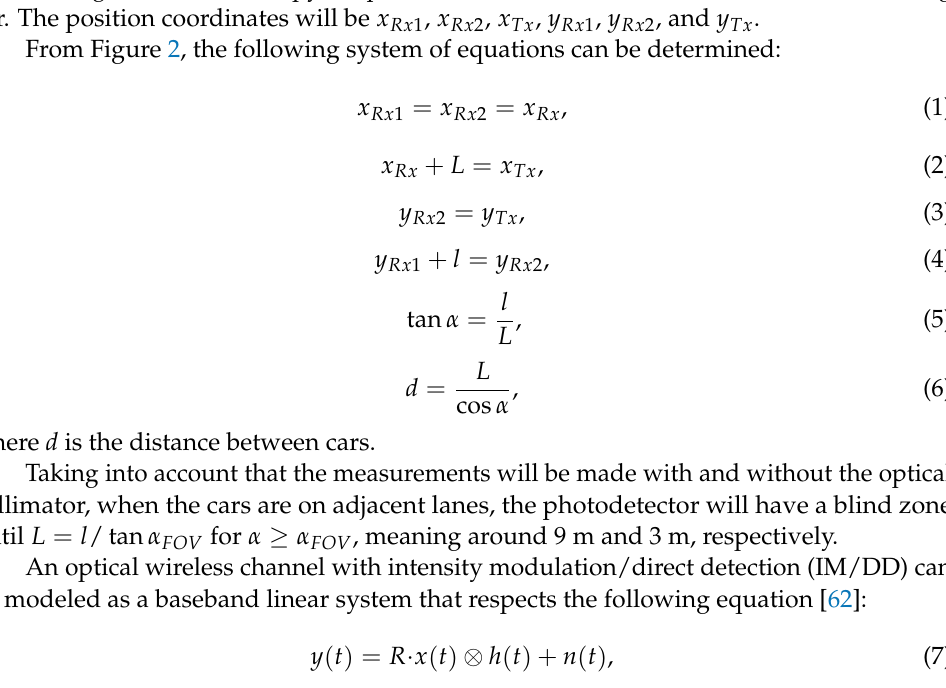
Figure 2. Vehicle configuration for analytical study.